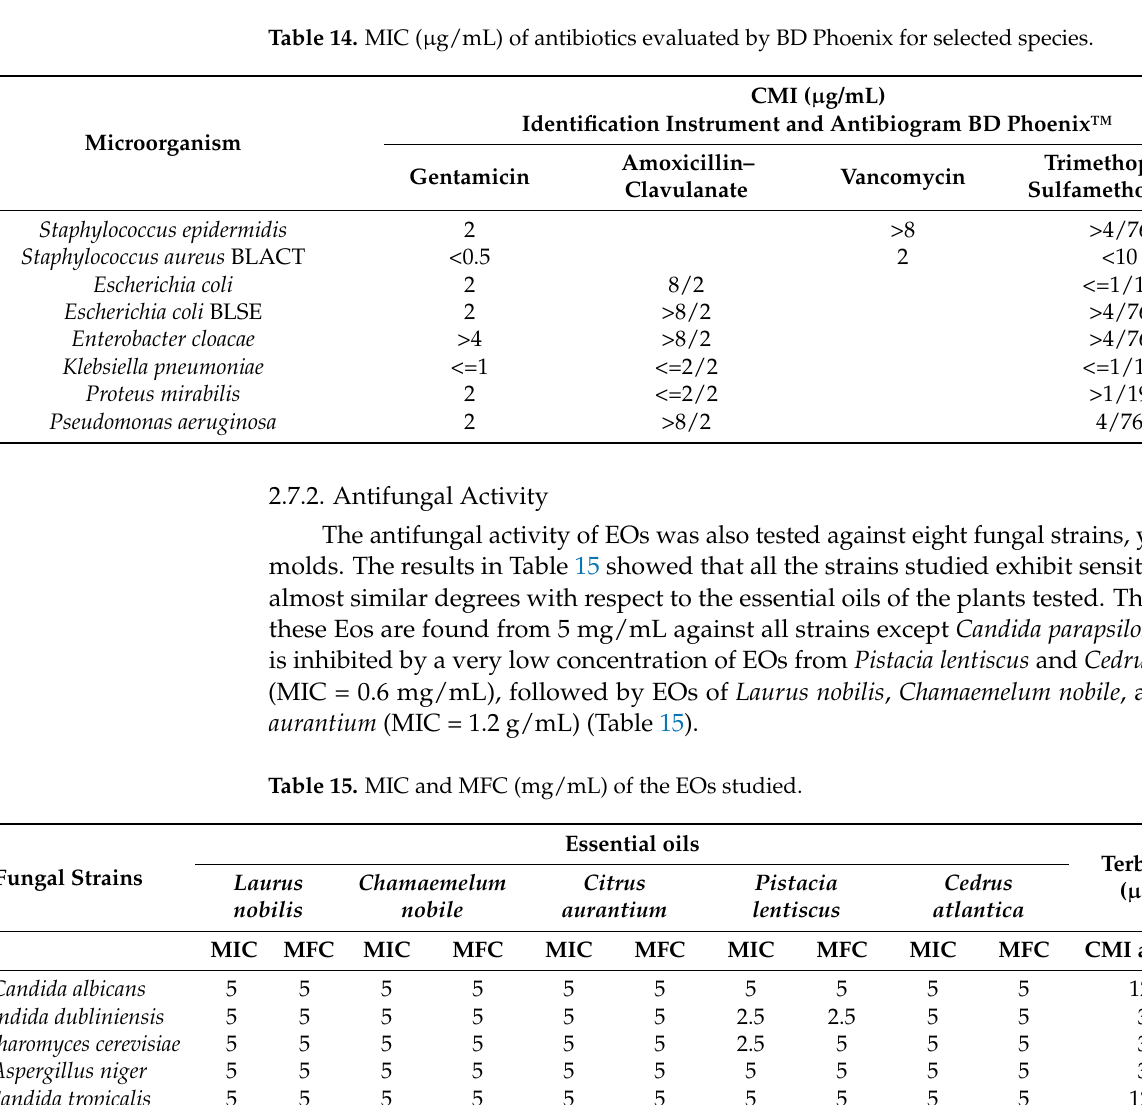
Table 14. MIC ( µ g/mL) of antibiotics evaluated by BD Phoenix for selected species.